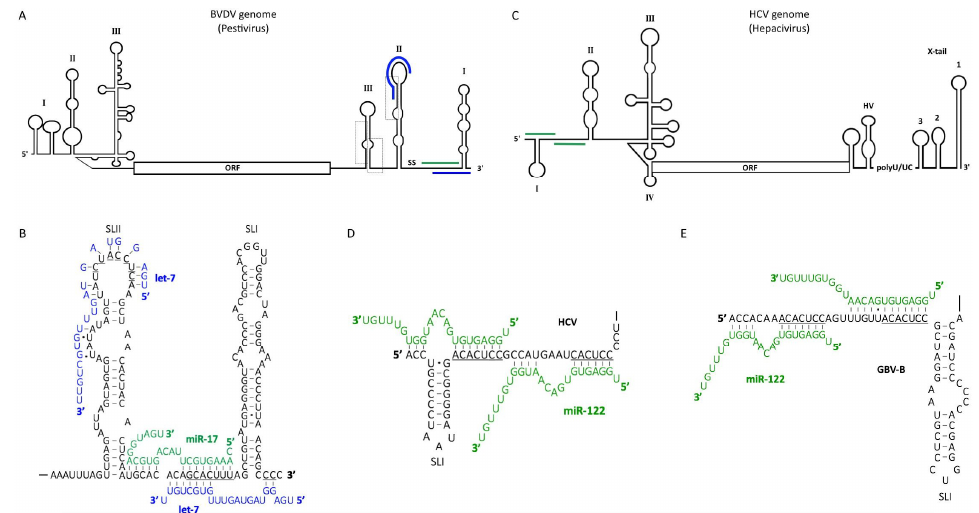
Figure 3. Genome organization and miRNA binding sites in the BVDV and HCV genomes. The coding regions of BVDV and HCV are flanked by 5′ and 3′ untranslated regions (UTRs) characterized by specific stem-loop (SL) structures. ( A ) The BVDV genome includes UGA box sequence elements (boxed), a single-stranded (ss) RNA region, let-7 (blue) and miR-17 (green) binding sites. ( B ) Model of the binding interactions between the BVDV 3′ UTR and miR-17 and let-7. ( C ) The HCV genome contains two miR-122 binding sites (green) and an IRES element, which includes SLII-IV in the 5′ UTR. The 3 (cid:48) UTR includes a hypervariable region (HV), a polyU/UC tract of variable length and a highly conserved 3 (cid:48) X-tail, comprised of SL1-3. MiR-122 binds to two tandem sites in the 5 (cid:48) UTRs of ( D ) HCV and ( E ) GBV-B. The nucleotides binding to the miRNA seed regions are